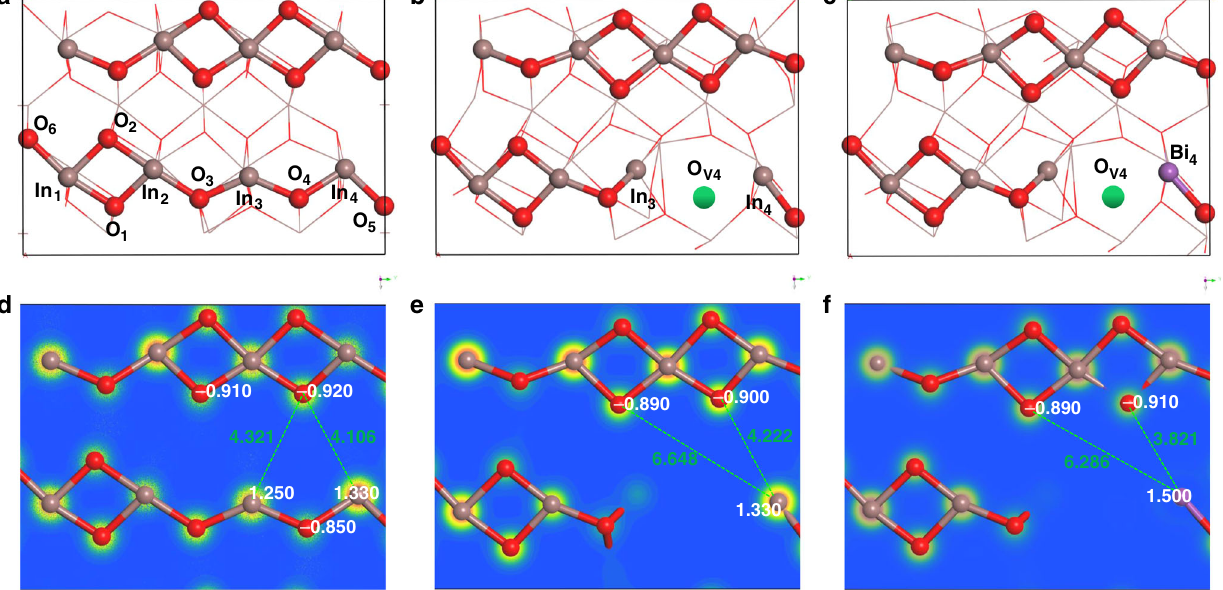
Fig. 6 Schematic images of the reactivity of SFLPs in single-site Bi 3 + substituted Bi x In 2 – x O 3 . a Optimized structure of perfect In 2 O 3 (110). b Optimized structure of defective In 2 O 3 (110) with one oxygen vacancy. c Optimized structure of Bi x In 2 – x O 3 (110) with Bi 3 + substitution. d Electron-density isosurface of perfect In 2 O 3 (110). e Electron-density isosurface of defective In 2 O 3 (110) with one oxygen vacancy. f Electron-density isosurface of Bi x In 2 – x O 3 (110) with Bi 3 +